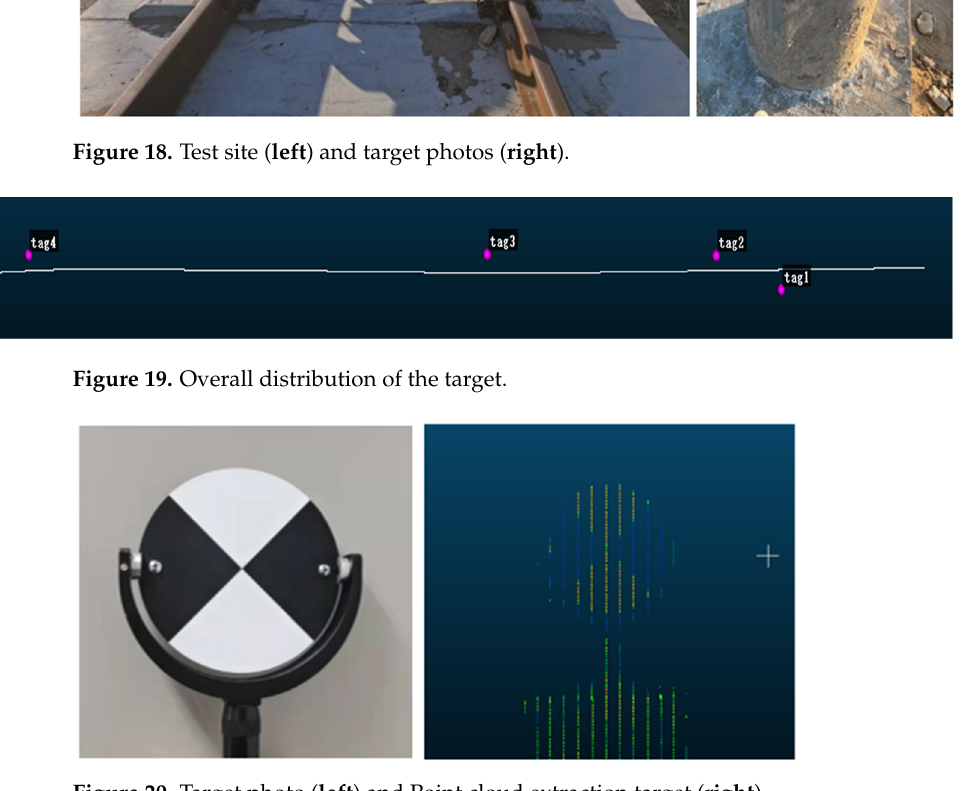
Figure 19. Overall distribution of the target.